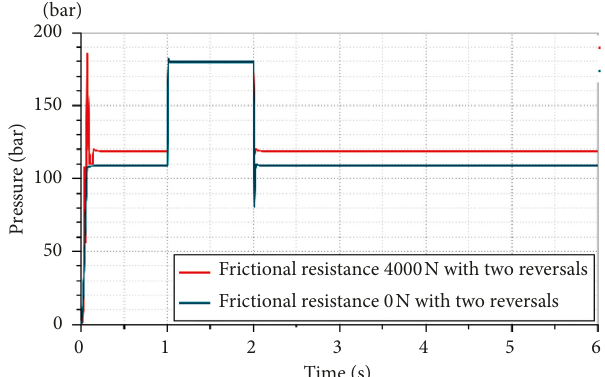
Figure 8: Pressure changes under frictional